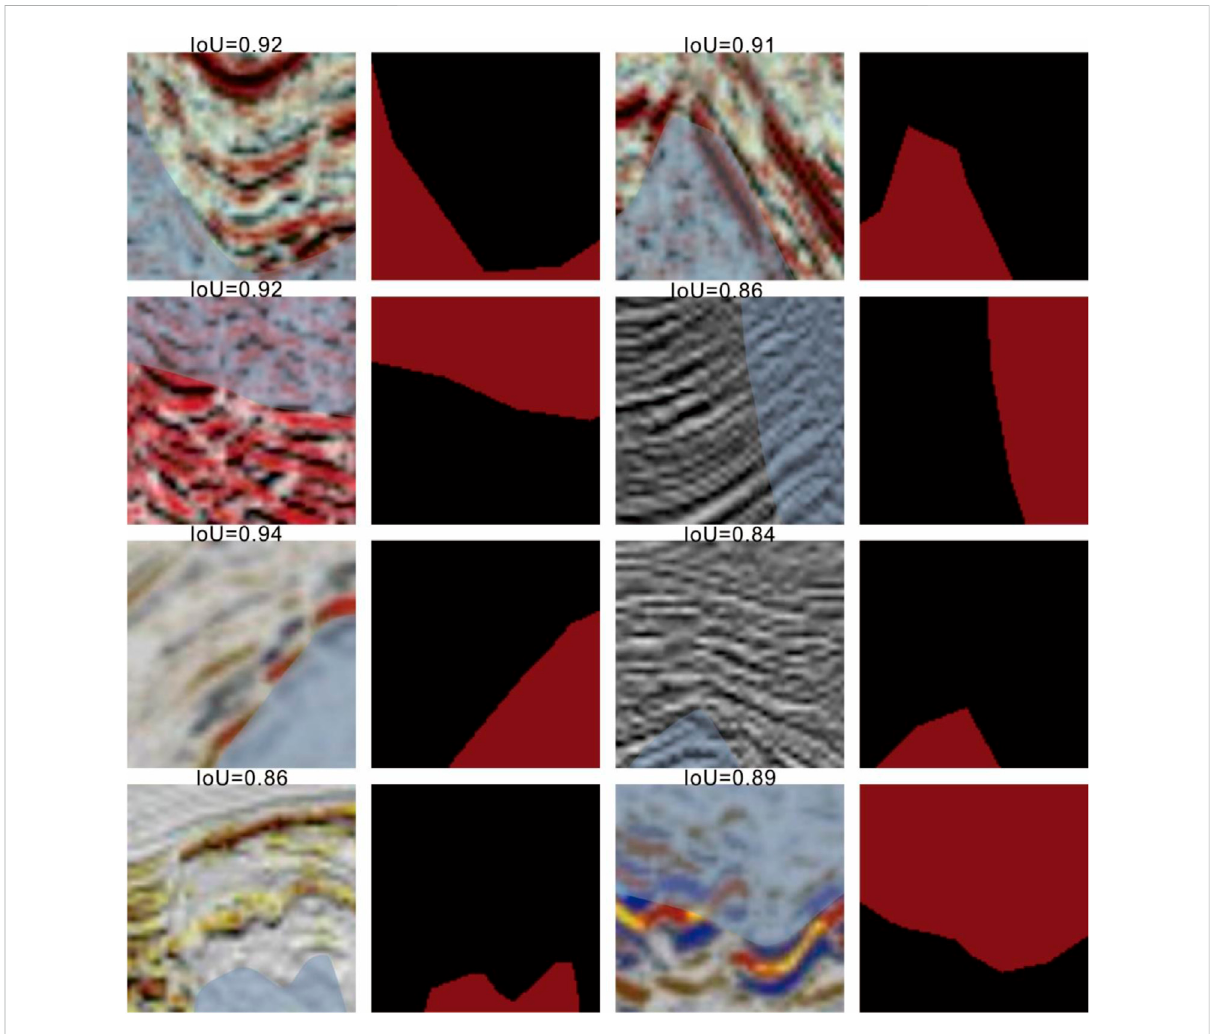
FIGURE 10 Thestage5performanceforsaltdetection,withintersectionoverunion(IoU)values(thebluepartisthesaltstructure;inthesegmentedimages, the red part is the salt structure and the black part is the